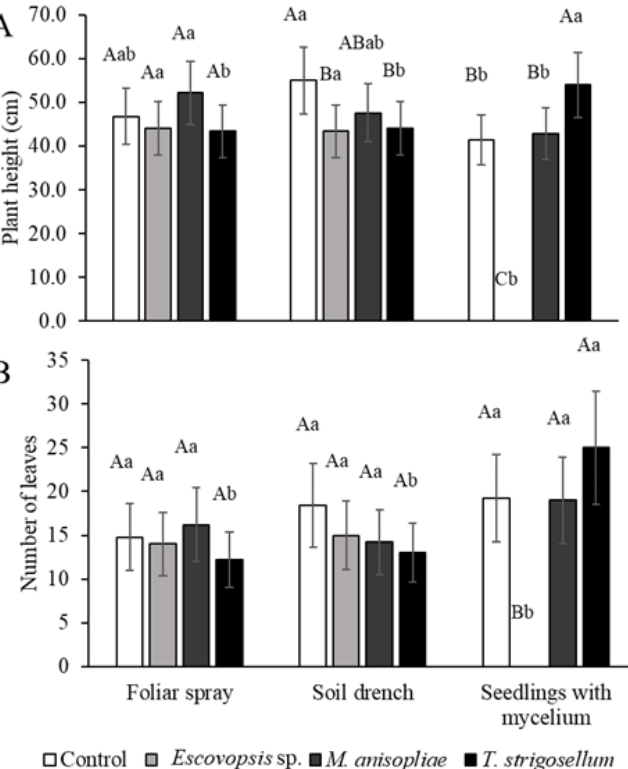
Figure 3. Biometric characteristics of E. urophylla in response to inoculation methods (Foliar spray, soil drench, and seedlings with mycelium) and inoculated fungal species ( Escovopsis sp., Metarhizium anisopliae , and Trichoderma strigosellum ). ( A ) Plant height (cm), and ( B ) Number of leaves per plant. Mean values with the same uppercase letter indicating the effects of the fungi or lowercase letter indicating the effects of the methods did not differ, as per Tukey test ( p < 0.05). Each column corresponds to the mean of five plants ± standard error